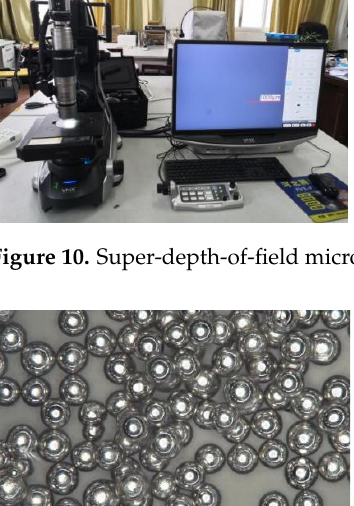
Figure 9. The 3 kW fiber laser cladding machine.